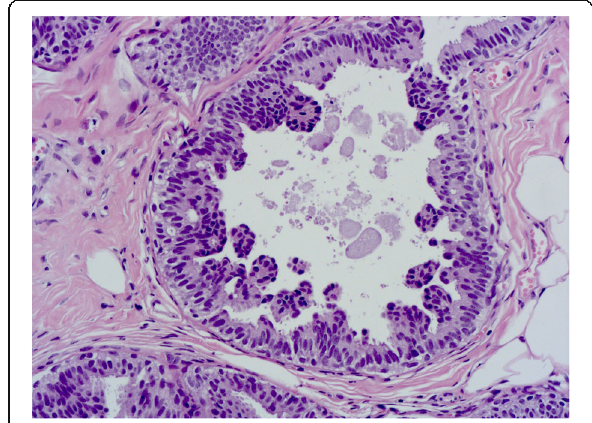
Fig. 8 Atypical ductal hyperplasia: mild nuclei atypia with crowding and complex architecture